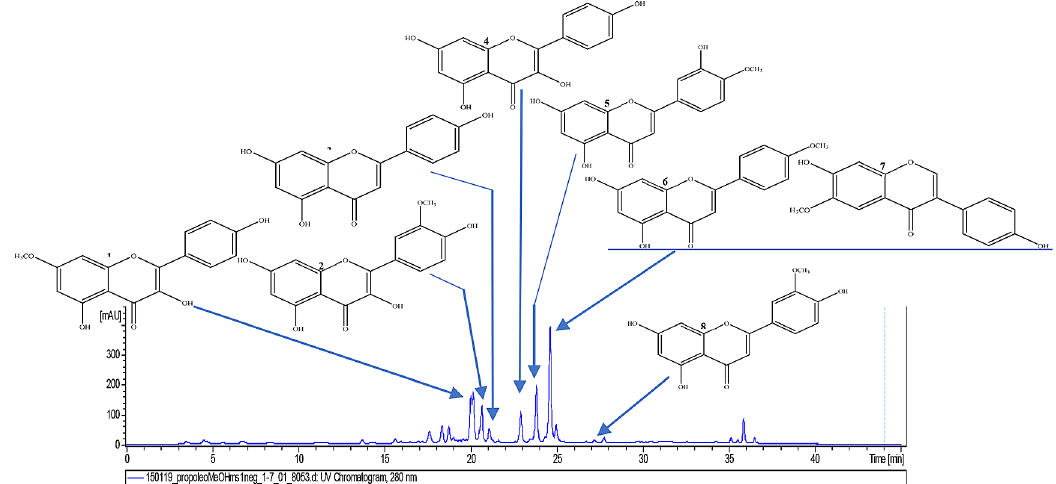
Table 2. Antibacterial effects of crude extracts of 13 Peruvian propolis isolates on strains of S. gordonii and F. nucleatum.